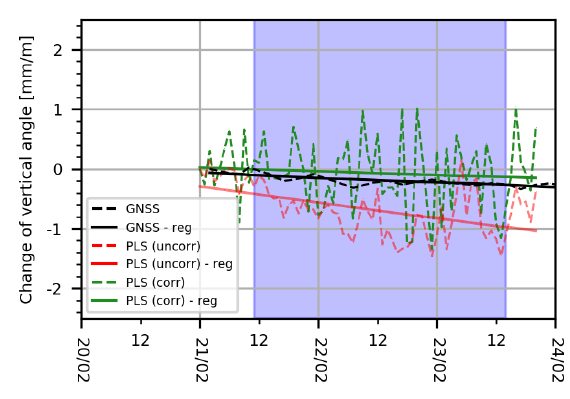
Figure 6. Angular change between container and horizontal: Comparison of the plane modelling from uncorrected (uncorr), corrected (corr) point cloud data (PLS) and the four GNSS antennas. The stormy periods are marked in blue. measurement accuracy. For the comparison, a linear regression (reg) is performed for each data set. The downward trend shows that the container inclines towards point MON 4 during the two storm days. The offset between the graphs indicates that the coordinate systems are not identical. The z-coordinate of the PLS is not perpendicular because the scanner is not